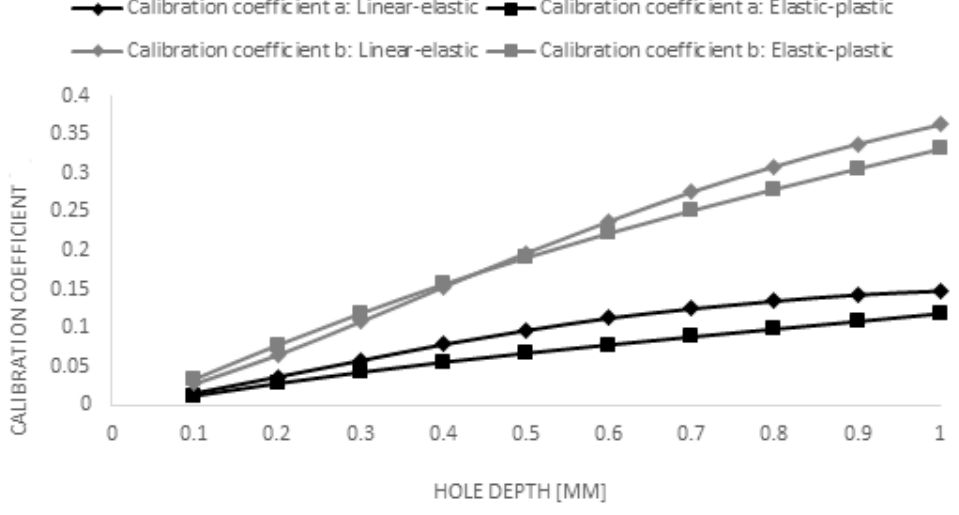
Figure 9. Comparison between linear-elastic and elastic-plastic material behavior from 3D